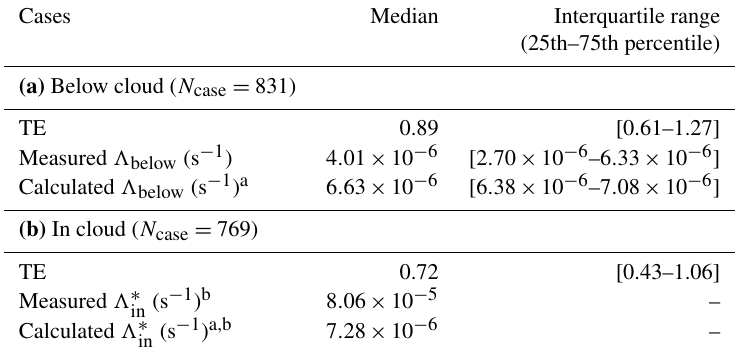
Table 2. Summaries of the transport efficiency (TE) and scavenging coefficients for selected (a) below- and (b) in-cloud cases based on ERA5 hourly data of pressure levels from ECMWF.